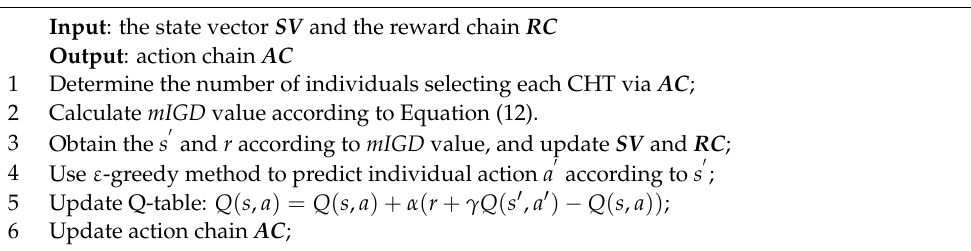
Algorithm 1: Adaptive Constraint Handling